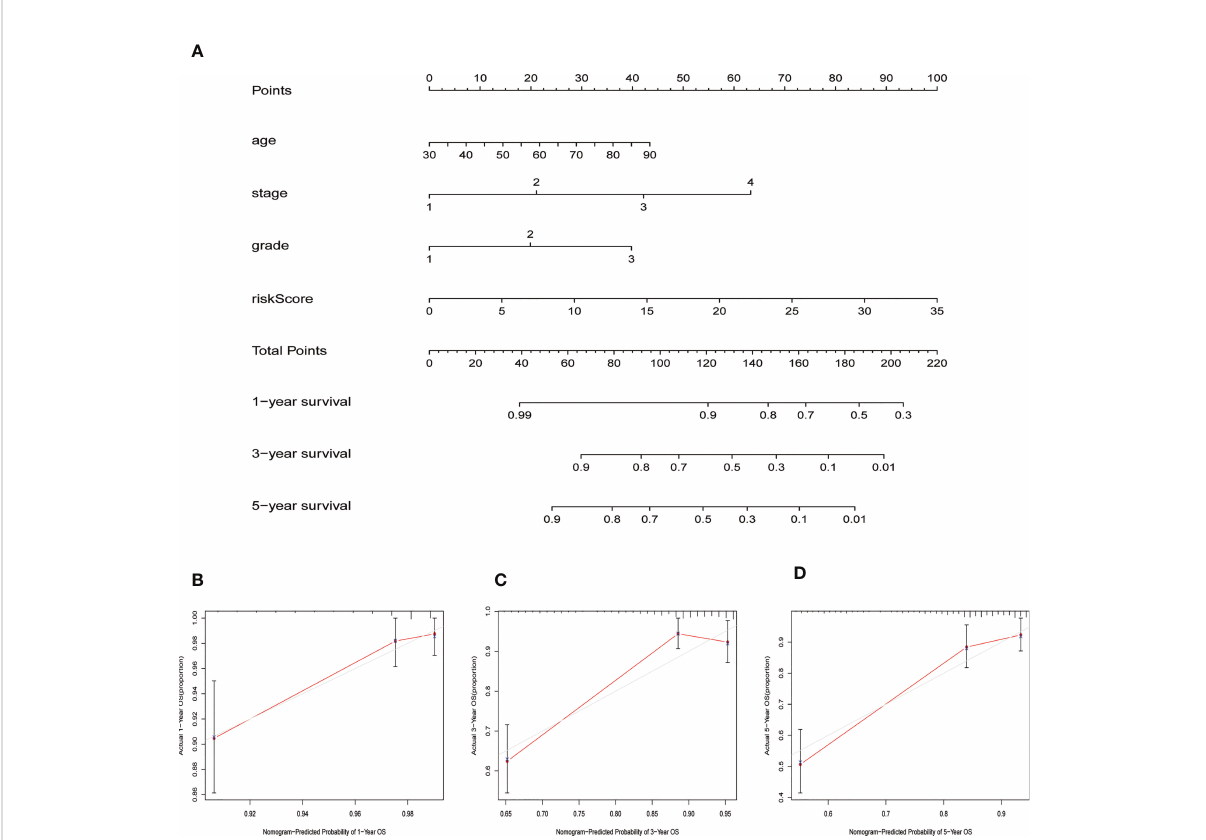
FIGURE 3 Construction of necroptosis-related lncRNA predictive model and lncRNA-mRNA network of seven necroptosis-related lncRNAs (NRLs). (A) Forest plot shows the HR and p value of 48 prognostic-related NRLs from the univariate Cox regression analysis. (B) Sankey diagram of prognostic NRLs, consisted offour protective factors and three risk factors. (C) Co-expression network for necroptosis-related genes and NRLs. (D) The expression pro fi les of the 7 NRLs in EC samples and normal